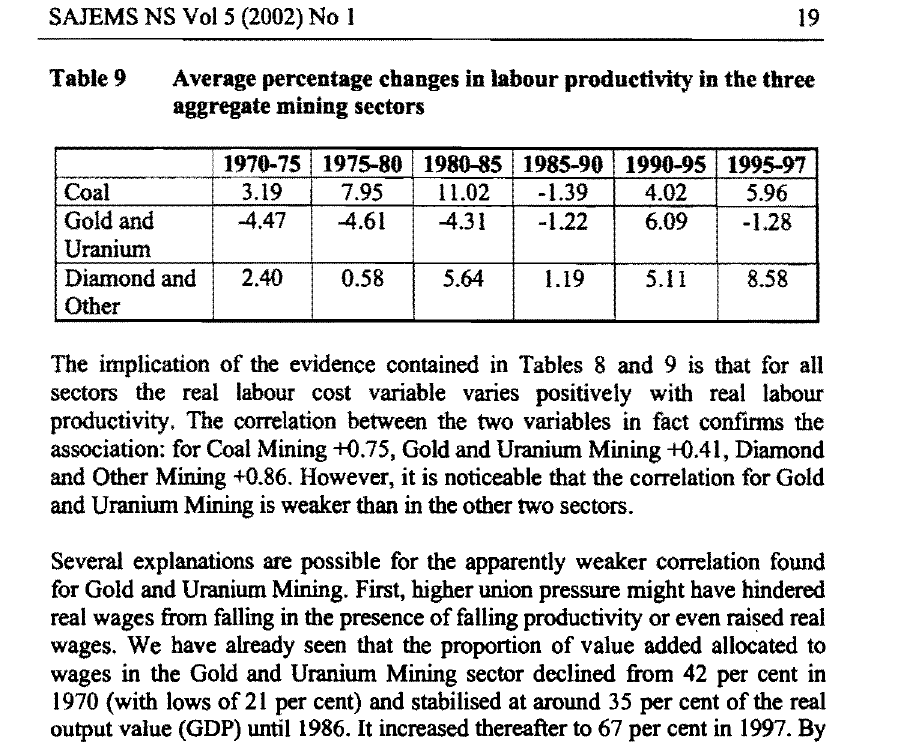
Average percentage changes in labour productivity in tbe three aggregate mining